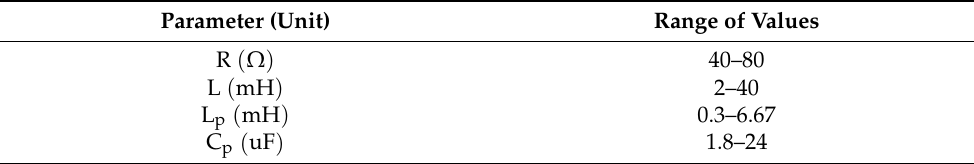
Table 2. Ranges of values for the HCB